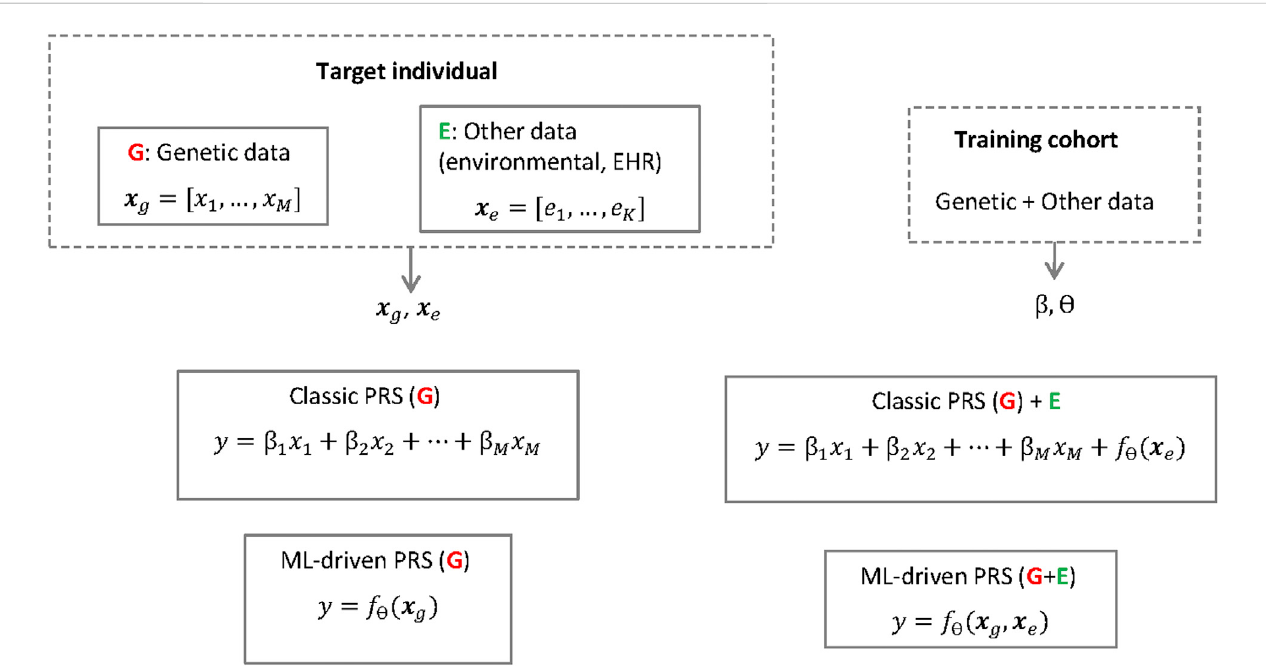
FIGURE 1 Classic PRSs and ML-driven PRSs thepolygenic risk score for atarget individual and phenotypeof interest (y) is based on the individual ’ s genetic data ( x g ) butcanalsoincludeotherdatatypes( x e ).Thescoreiscalculatedusingalinearregression(withweights β )oramachinelearningmodel f θ (e.g.aneuralnetwork with parameters θ ). The parameters ( β , θ ) are learned using a separate training cohort. Note, however, that while the linear regession cof fi cients β are